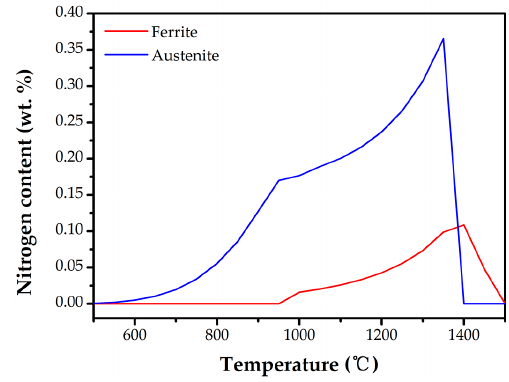
Figure 5. The nitrogen solubility vs. temperature in ferrite and austenite.